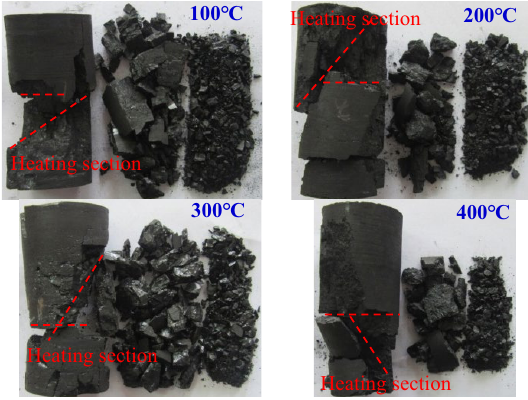
Figure 14. Failure mode when 40% of the height of the coal sample were heated.